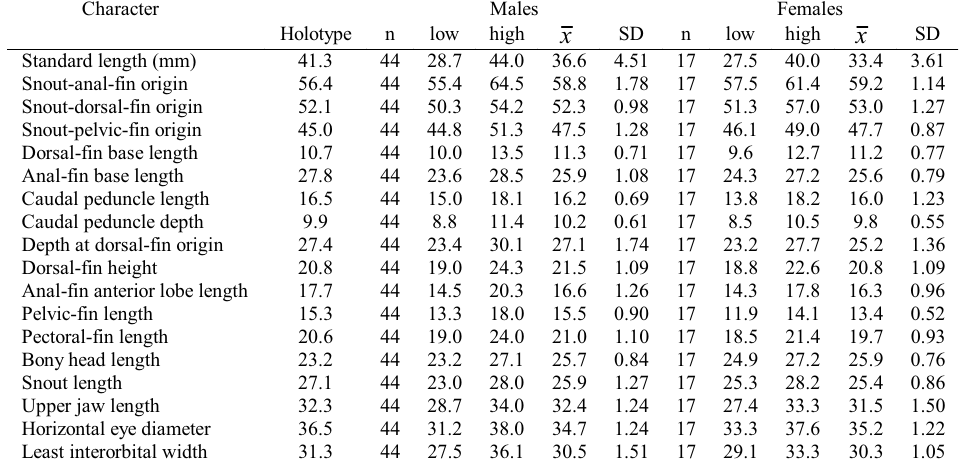
Table 1. Morphometrics of Bryconadenos tanaothoros . Standard length is expressed in mm; measurements through head length are percentages of standard length; the last four entries are percentages of head length. All specimens are from the following lots. Holotype: MZUSP 85852; paratypes: MZUSP 62102, MZUSP79752, MCP 29467, LIRP 4087, USNM 352061.